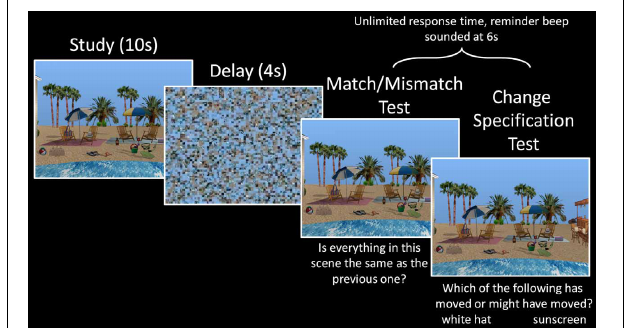
FIGURE 2 | Trial structure of Experiment 1. A scene exemplar was studied for 10s during the sample phase, followed by a 4s delay, and then a probe phase, where either the same scene exemplar or its manipulated version appeared. During the probe phase, participants first indicated whether the probe was an exact match to the sample scene they had just studied, and then attempted to identify the object that had changed locations (or might have changed locations, in cases where they thought the probe was a